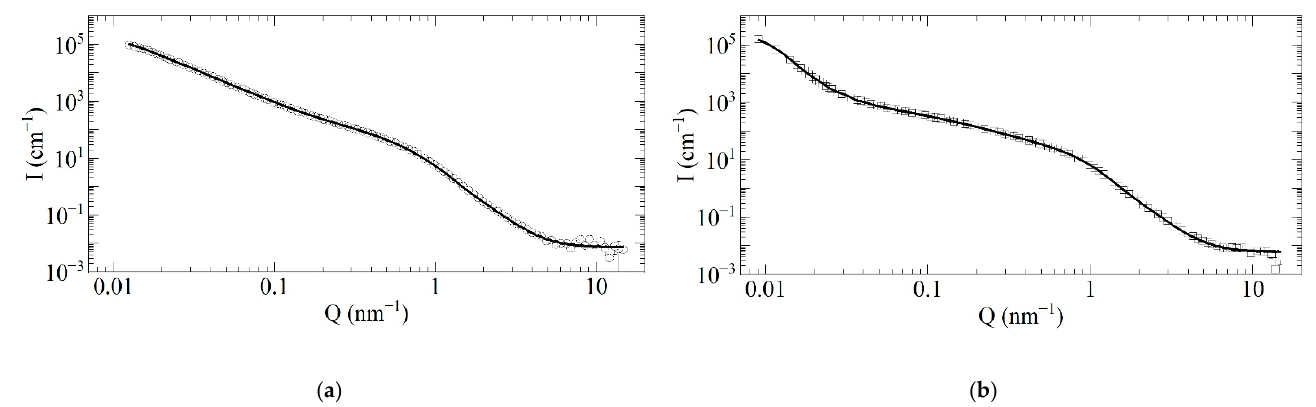
Figure 7. Comparison of measured (open circles and squares) and simulated (solid lines) scattering intensity I (cm − 1 ) versus the neutron-transferred momentum Q (nm − 1 ): ( a ) F-DND; ( b ) DF-DND samples.